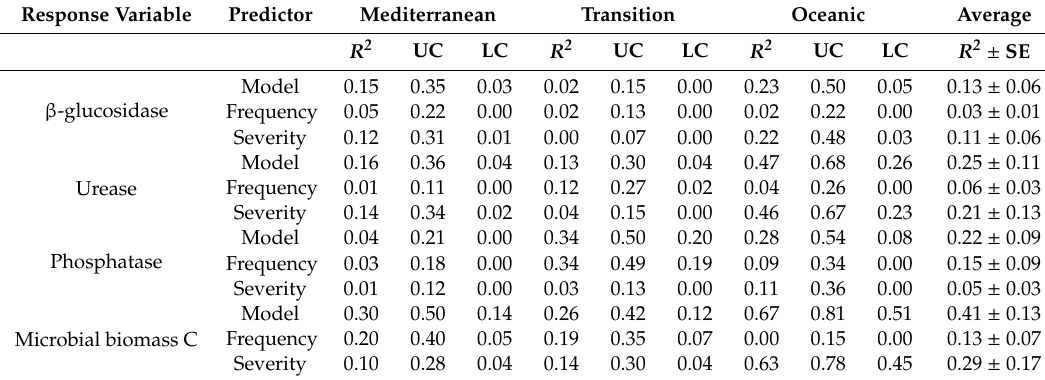
Table 1. Mean generalized R 2 for the Generalized Linear Mixed Models (GLMMs), semi-partial R 2 for each model predictor (fire frequency and burn severity), and 95% confidence levels for the R 2 values (UC: upper confidence level; LC: lower confidence level) [‘ r2beta ()’ outputs] at each study site (Mediterranean, Transition, and Oceanic) and average values of the three study sites. Significant interactions between frequency and severity were not found. SE = standard